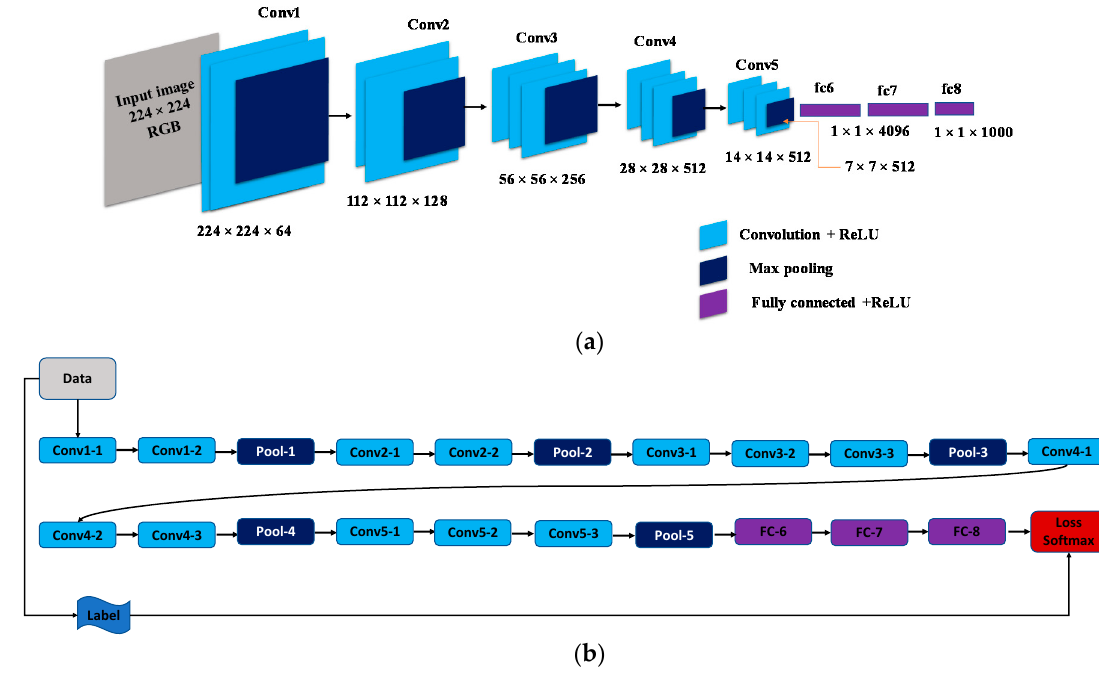
Figure 1. General Structure of the VGG-16 network: ( a ) Convolution layers of the VGG-16 network, and ( b ) data flow in the VGG-16 network [20].